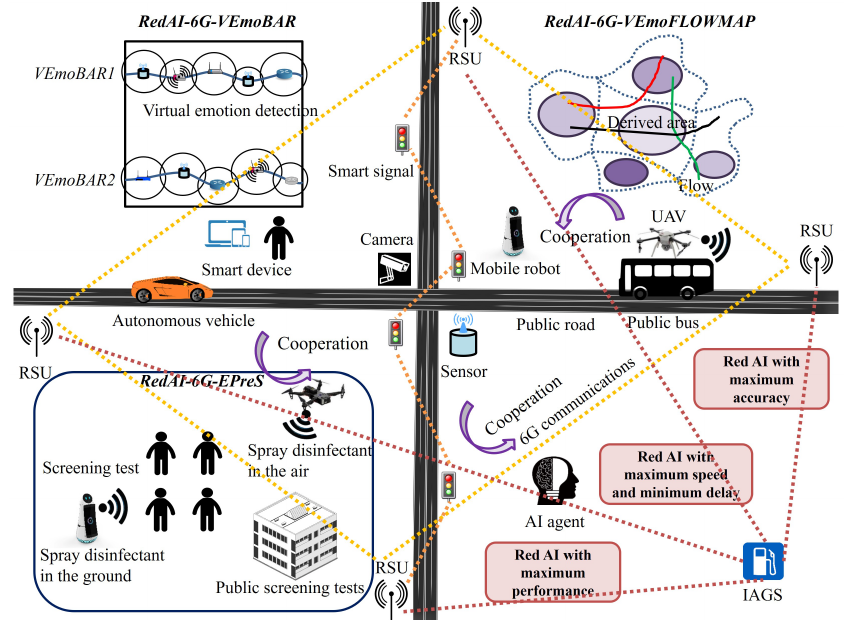
Figure 4. A depiction of applications with main components, operations and objectives including RedAI-6G-VEmoBAR , RedAI-6G-VEmoFLOWMAP , and RedAI-6G-EPreS with Red AI